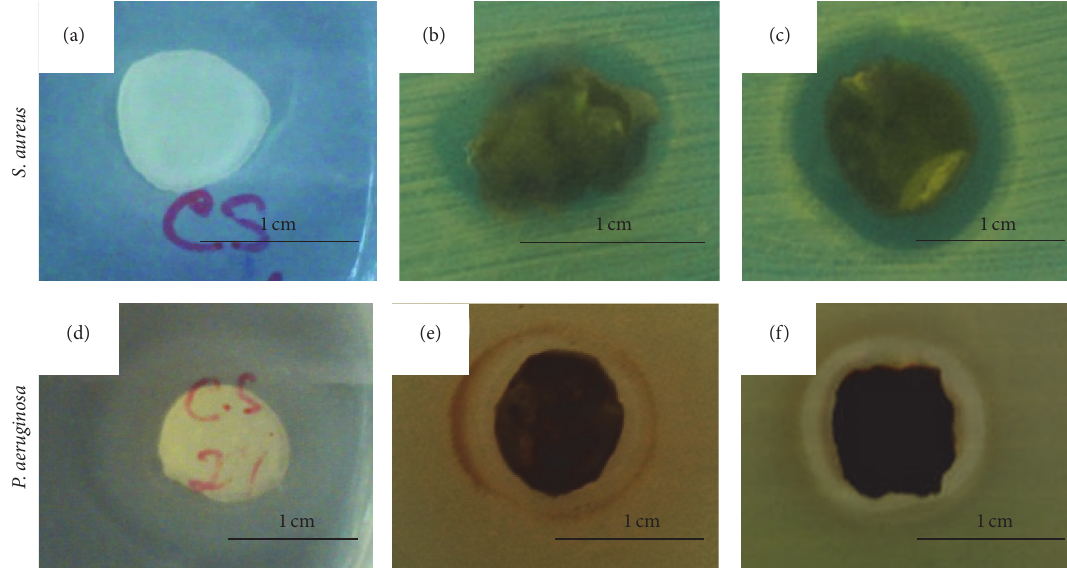
Figure 6: Antimicrobial activity against S. aureus (a–c) and P. aeruginosa (d–f) of CP (a and d), CPA 0.5 (b and e), and CPA 1 (c and f).